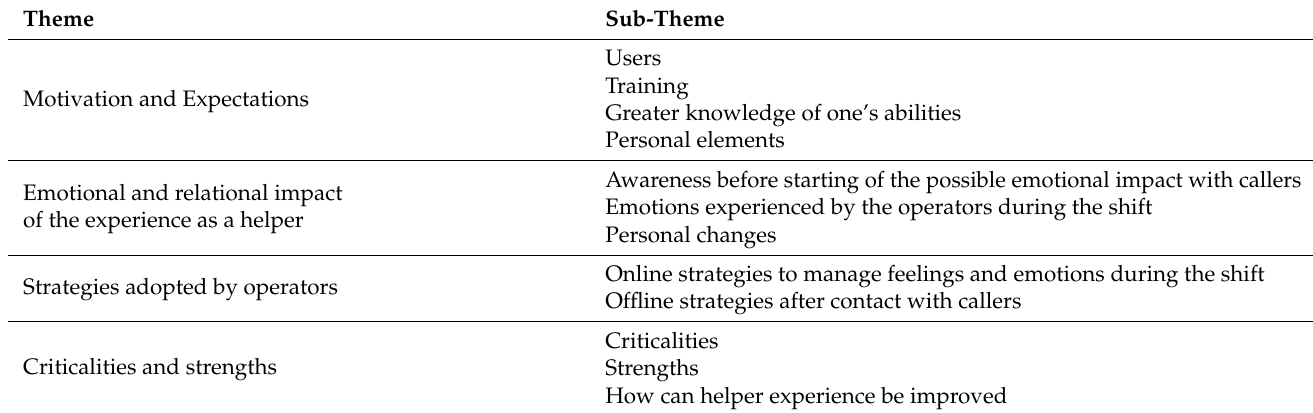
Table 2. Themes and sub-themes obtained from the thematic